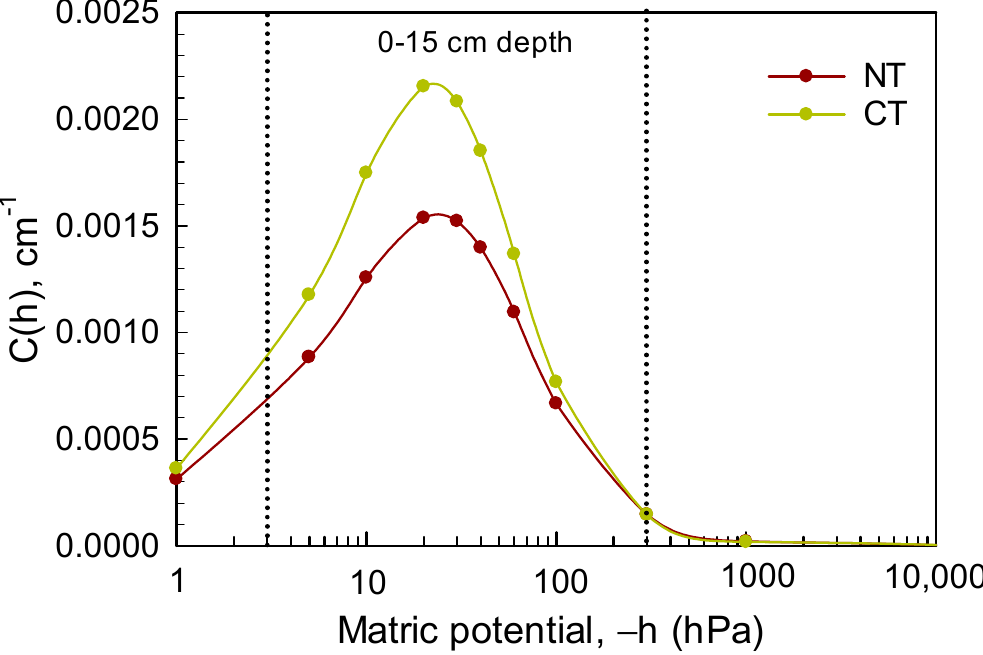
Figure 3. Unimodal pore size distribution showing the slope (C(h)) as a function of matric potential (h) for no-tillage (NT) and conventional tillage (CT) at 0–15 cm soil depth. The dotted lines represent size separation of soil pores.